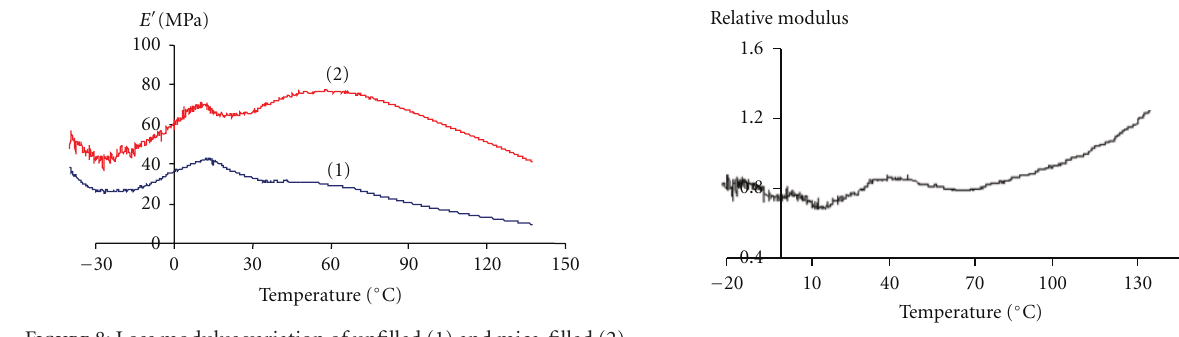
Figure 10: Relative damping